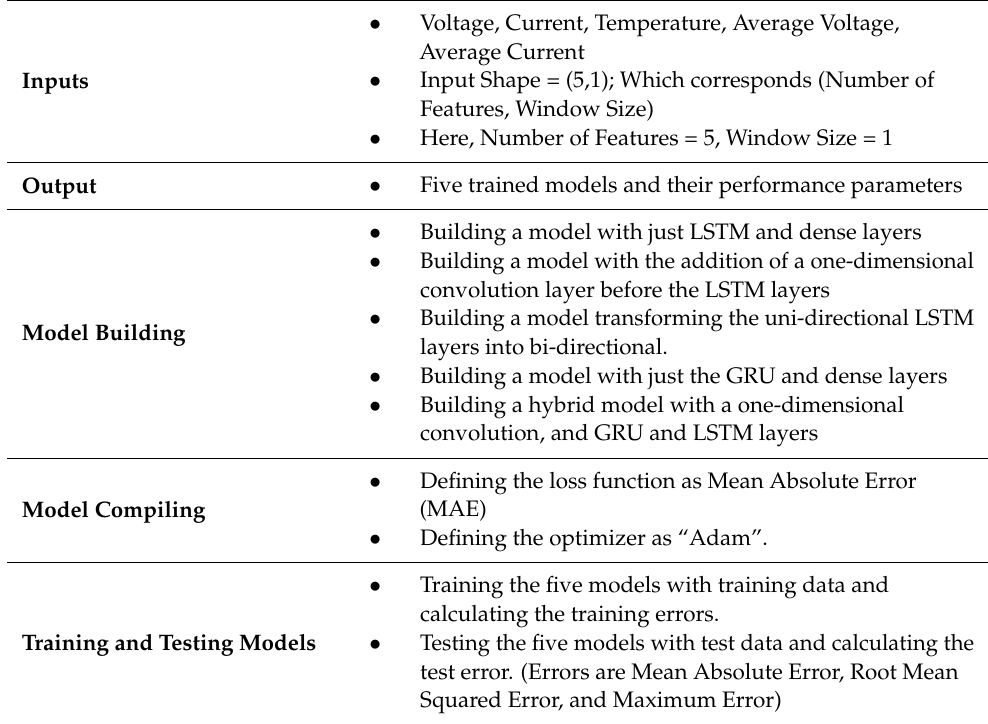
Algorithm 1. The model building and training method for the SOC